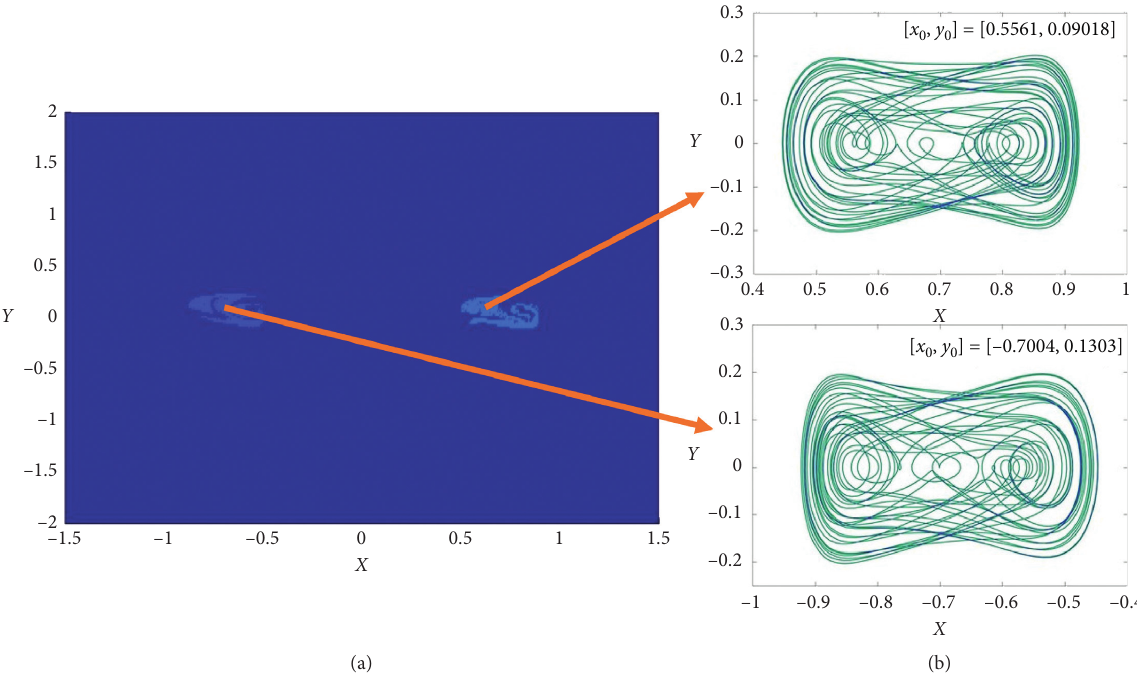
Figure 16: Cross section of the basins of attraction of the two coexisting attractors in the x - y -plane (Case